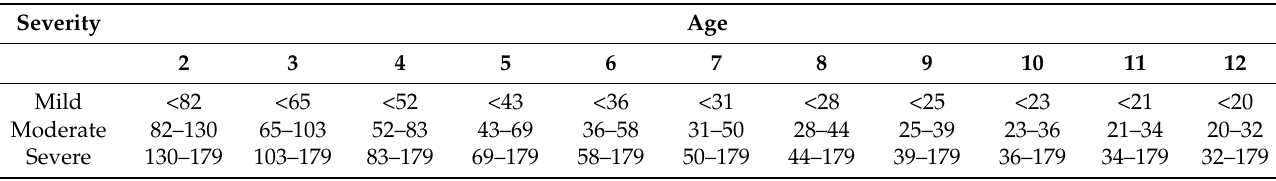
Table 1. Approximate relationship between Autism Treatment Evaluation Checklist (ATEC) total score, age, and Autism Spectrum Disorder (ASD) severity as described in Mahapatra et al. [19]. At any age, a greater ATEC score indicates greater ASD